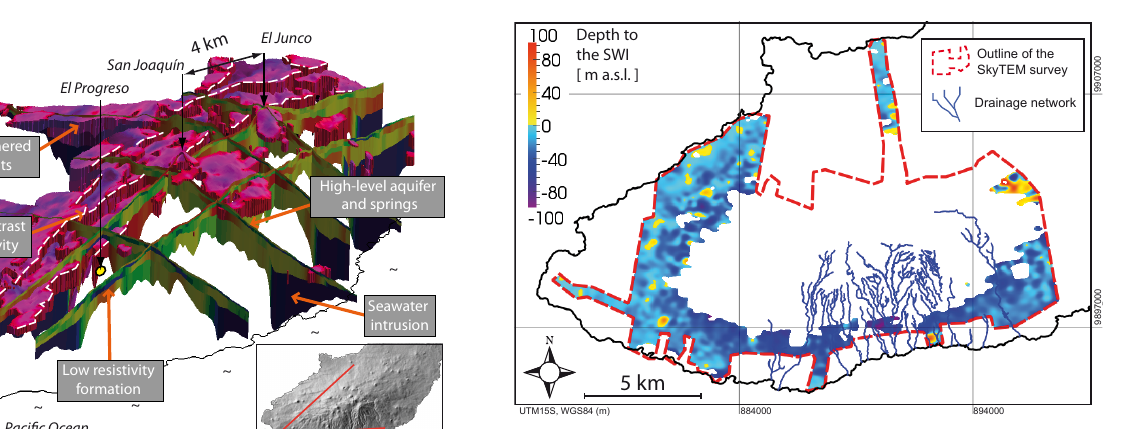
Fig. 5. 3-D view of the SkyTEM 4-layer resistivity model. The high resistivity extraction (threshold of resistivity > 400 (cid:127) m) re- veals sharp transitions in resistivity. The edges of the high resistivity extraction (white, dashed lines) correspond to the boundaries of the buried low-resistivity channel (Sect. 3.2.4). These edges are aligned with eruptive cones at the surface, which suggests the alignement with a dyke swarm.